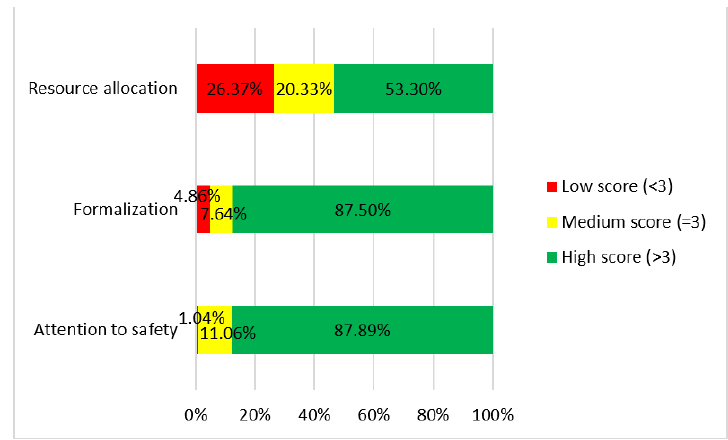
Figure 3. Global percentages of categorized BARS.